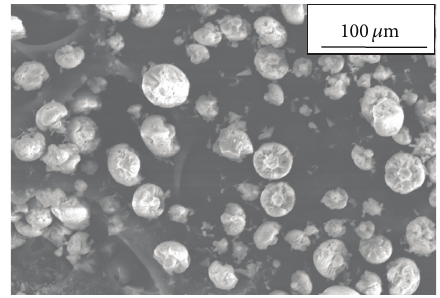
Figure 4: The SEM photograph of NiP.